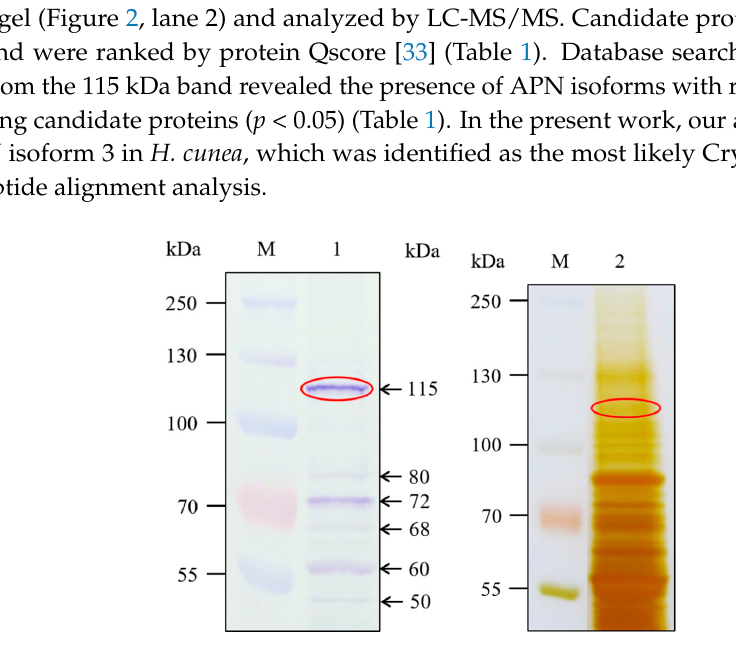
Figure 2. Ligand blot assay of H. cunea BBMV proteins (20 μ g) immunodetected with anti-Cry1Ab35 antibodies. Lane M shows molecular weight markers. Ligand blot conducted with Cry1Ab35 toxin is shown in lane 1. SDS-PAGE (10%) profile of H. cunea BBMV proteins is shown in lane 2. Ellipses indicate SDS-PAGE band excised and analyzed by LC-MS/MS.